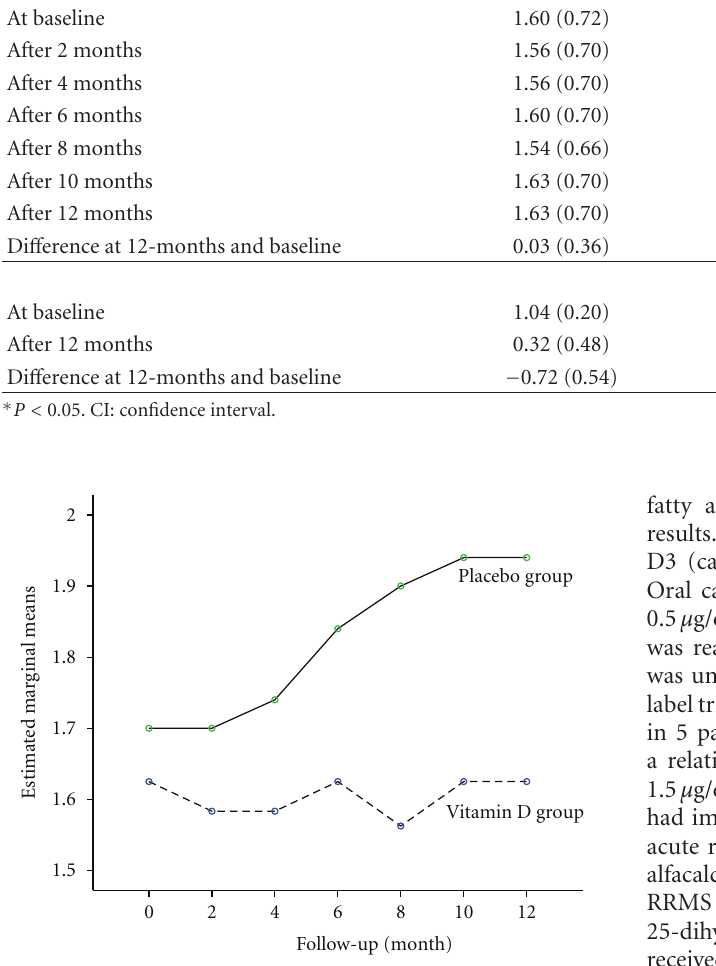
Figure 2: Estimated mean changes in Expanded Disability Status Scale after 2, 4, 6, 8, 10, 12 months of